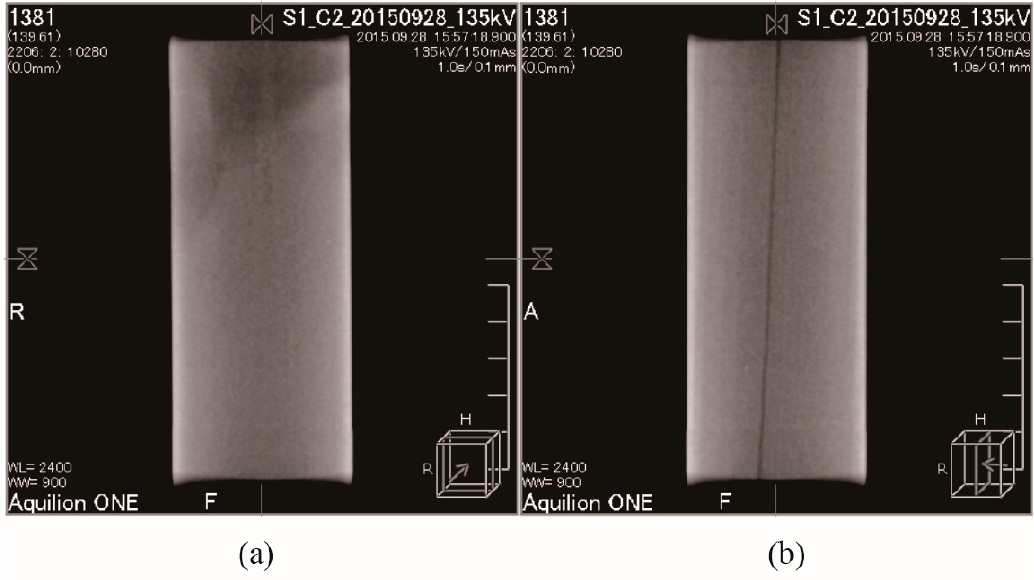
Figure 1. X-ray CT images of the shale sample along two perpendicular scanning directions (indicated in the bottom right corner of each image) in the central position. ( a , b ) Scanning slices are parallel with and perpendicular to the bedding planes, respectively.